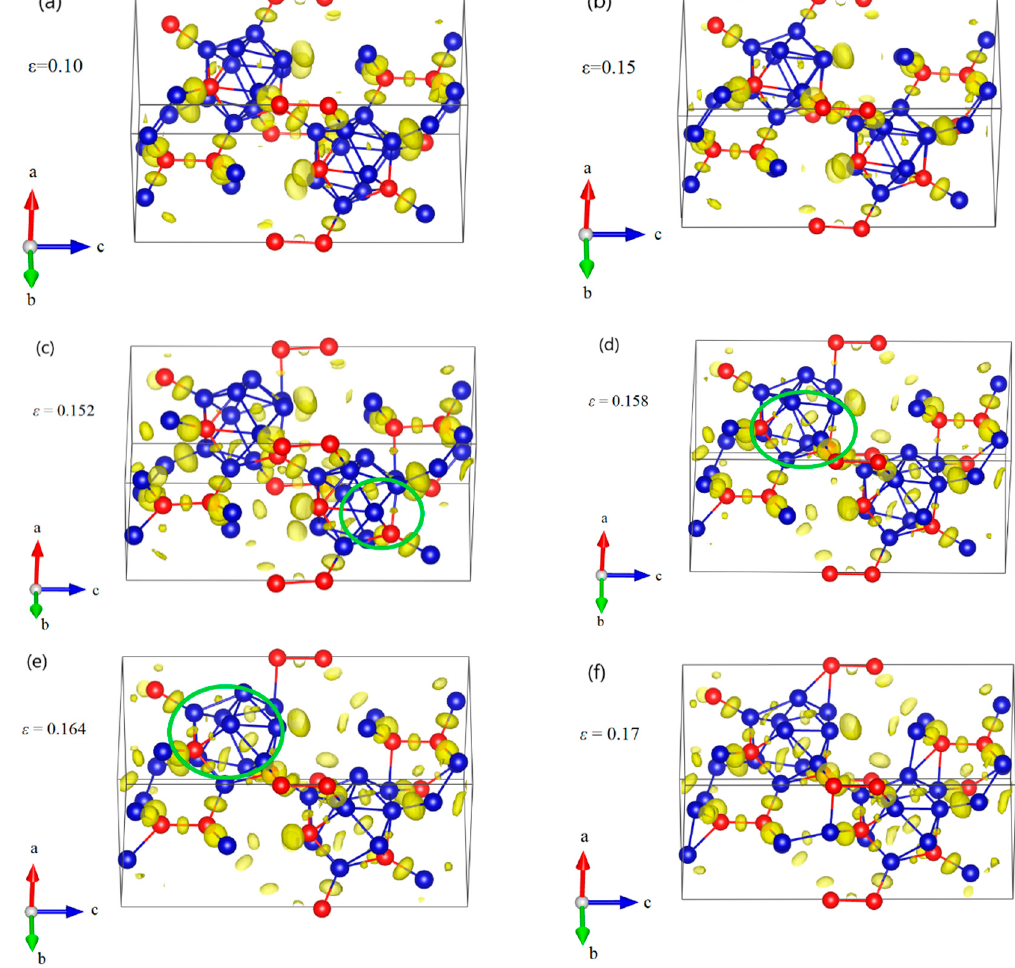
Figure 8. The structural changes and ELF at various critical strains for B 10 C 2P –CC structure under a axis uniaxial compression: ( a ) the structure at ε =0.10 in elastic deformation stage; ( b ) the structure at ε = 0.15 relating to the maximum stress, where the icosahedra are intact; ( c ) the structure at ε = 0.152 after the first stress drop, where one of the B–C P bonds within the icosahedron is broken; ( d ) the structure at ε = 0.158 after the second stress drop, where all B–C P bonds within icosahedra are broken; ( e ) the structure at ε = 0.164, where the icosahedra are gradually damaged; ( f ) the structure at ε = 0.17 where the structure fails due to the fully destruction of icosahedra (Blue = B atoms; red = C atoms).